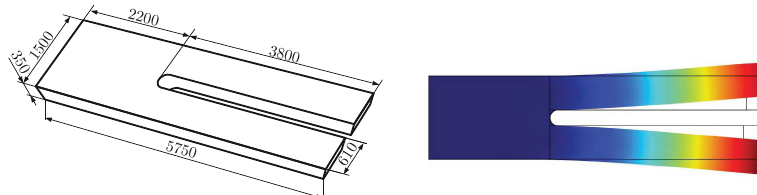
Figure 1. Left : Dimensions of the tuning forks ( µ m) used in the described applications. Right : The fundamental in-plane mode shape of the vibration simulated using finite element analysis. The eigenfrequency is 32.7